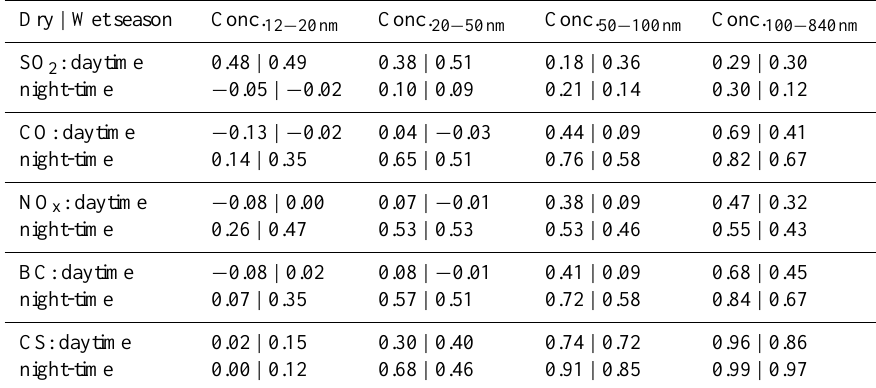
Table 2. Here Pearson correlation coefficients ( r) between various trace parameters and particle concentrations are presented. Particle number